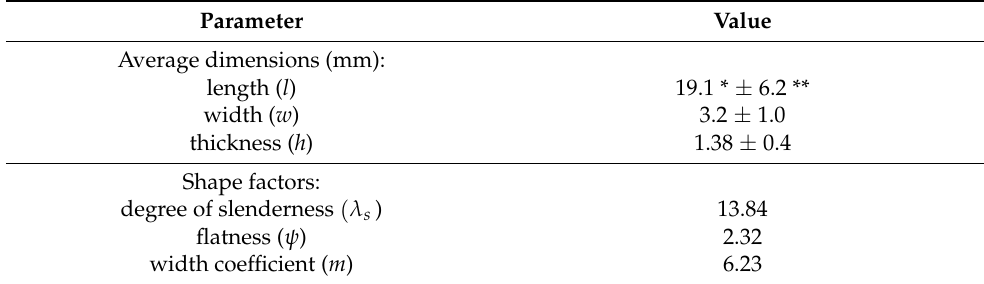
Table 1. Characteristics of PCL particles of the predominant